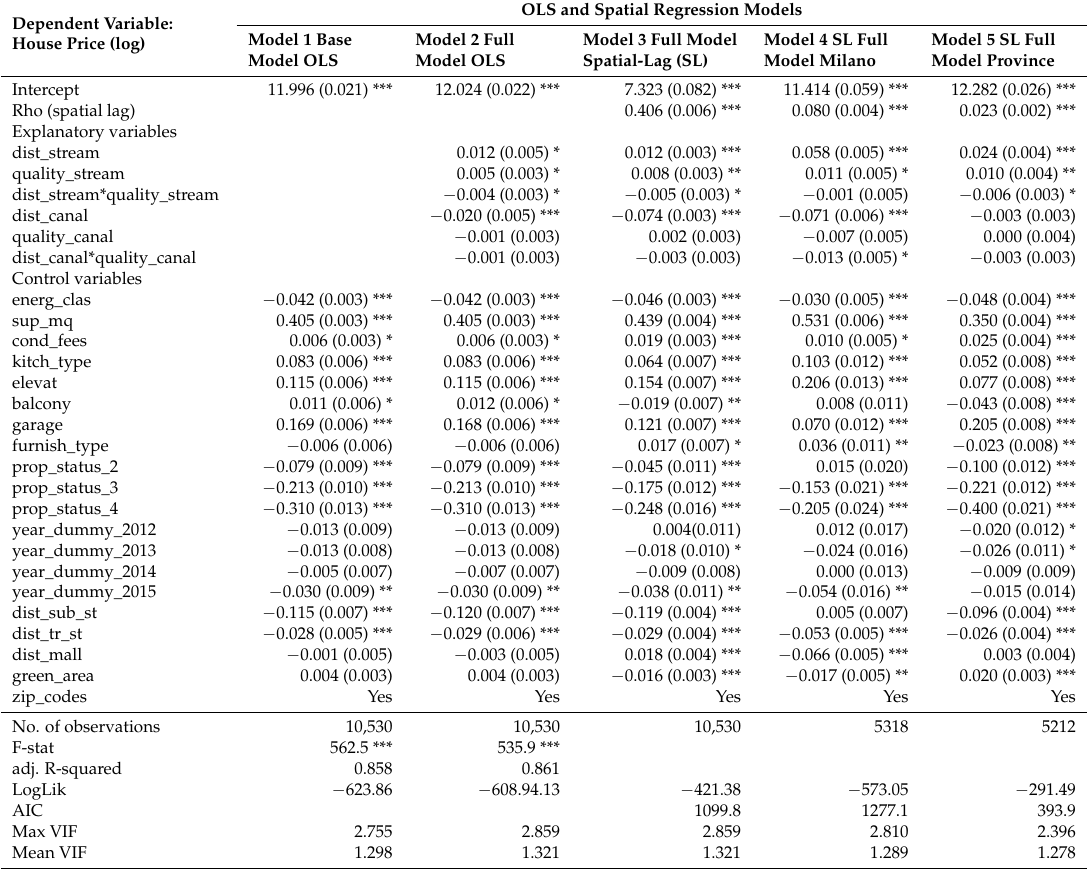
Table 4. Regression models